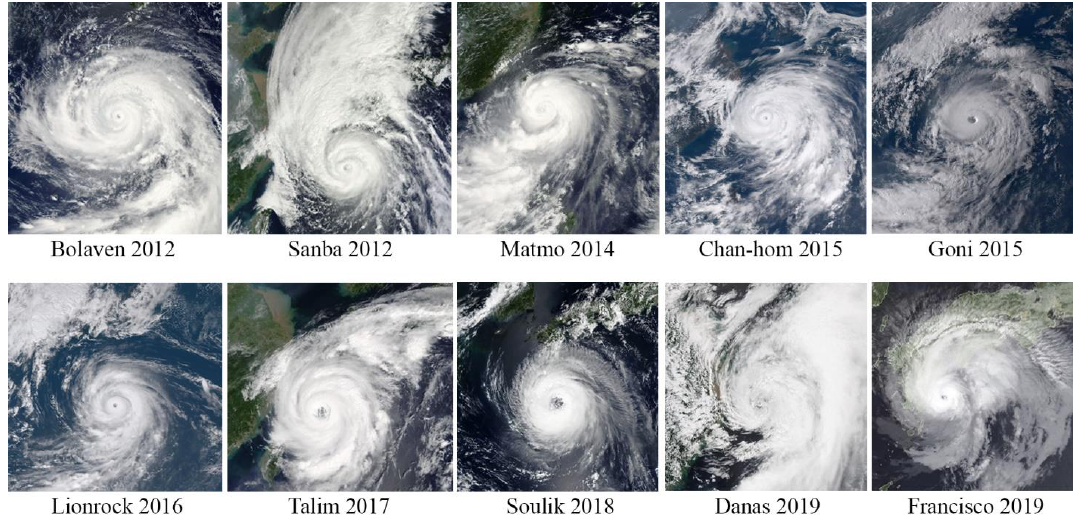
Figure 2. Suomi NPP images of studied tropical cyclones.